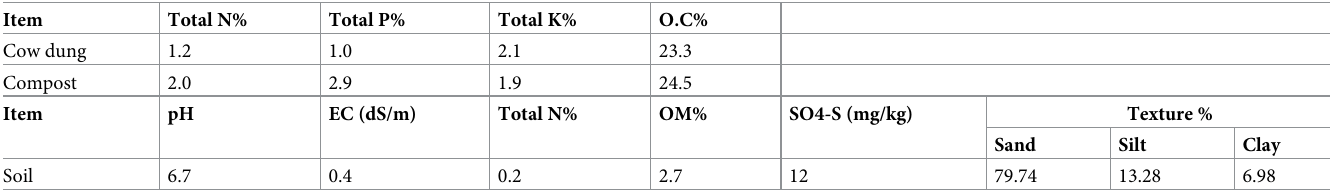
Table 1. Physiochemical properties of experimental soil and organic manures used in the first pot